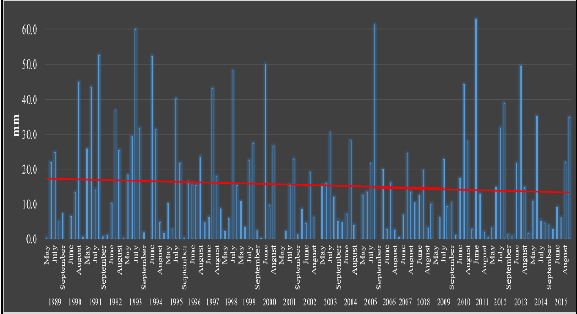
Figure 2. A long term of precipitation in study area from